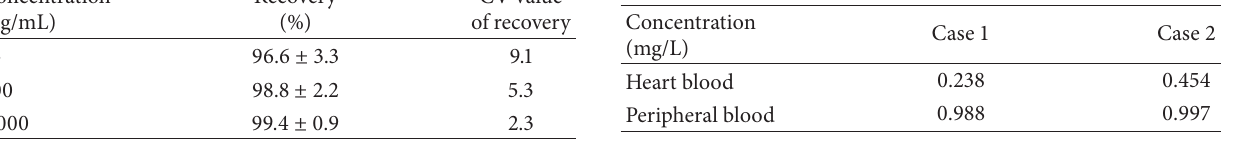
Table 4: Propofol concentration of authentic human heart blood and peripheral